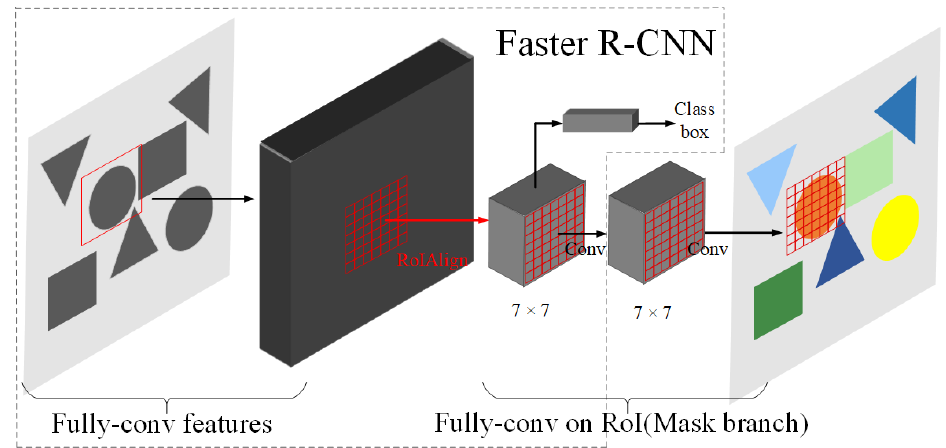
Figure 1. Mask R-CNN: add mask branch to Faster R-CNN.